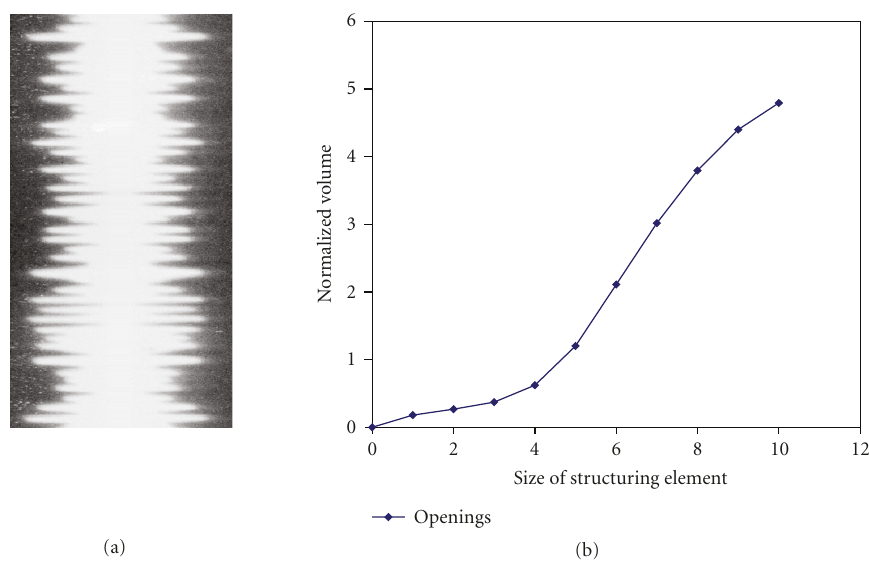
Figure 11: (a): overexposed soundtrack. (b): the corresponding graph: size of structuring element versus normalized volume (sum of gray values) of the di ff erence between the original image and its successive openings.